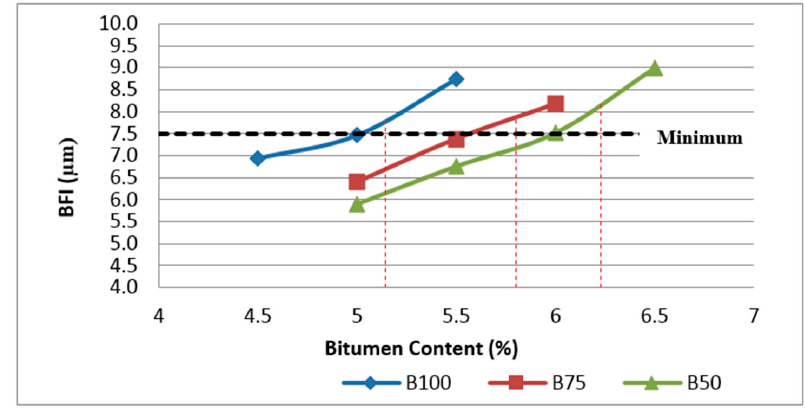
Figure 9. Effect of bitumen content and RCA content on BFI of Mix I containing virgin aggregate and Mix II and Mix III containing RCA as coarse aggregate.